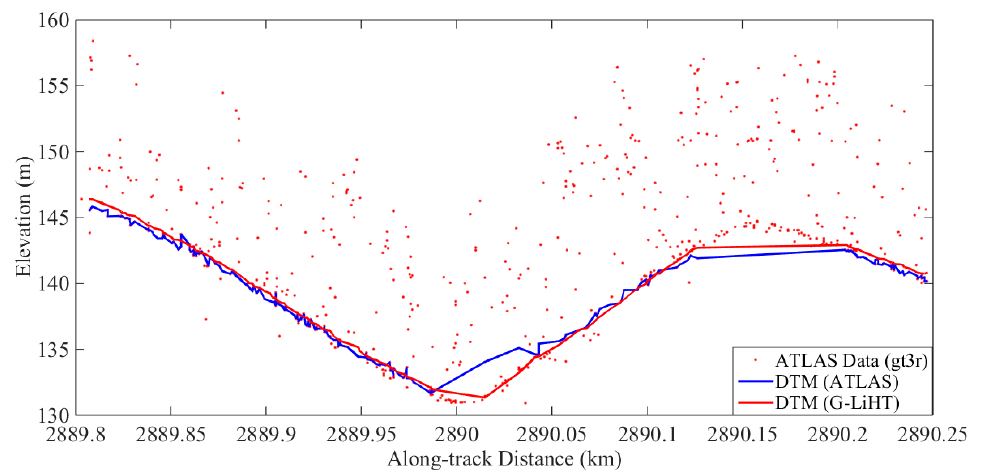
Figure 7. A subset of the forested terrain ATL03 (gt3r) ground topography validation results from track ATL03_20181226053112_13530106_001_01. The ATLAS photon data are shown as red dots. The ATLAS DTM (blue line) and the G-LiHT DTM (red line) are also shown.